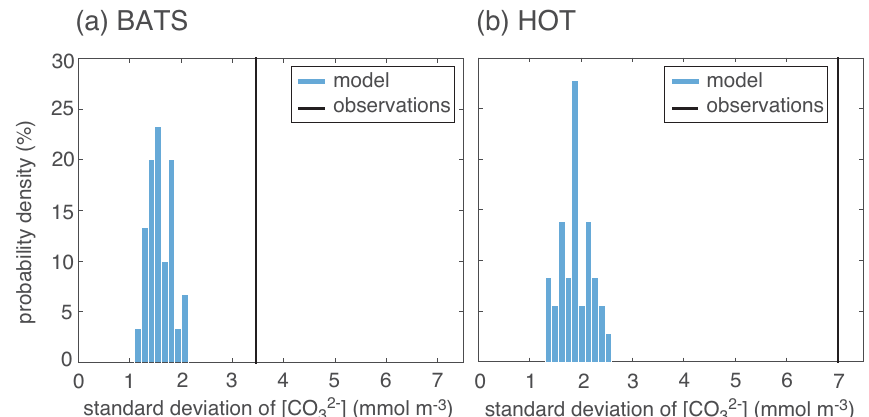
] at (a) BATS, based on 30 independent 30-year 3 ] at (a) BATS 3